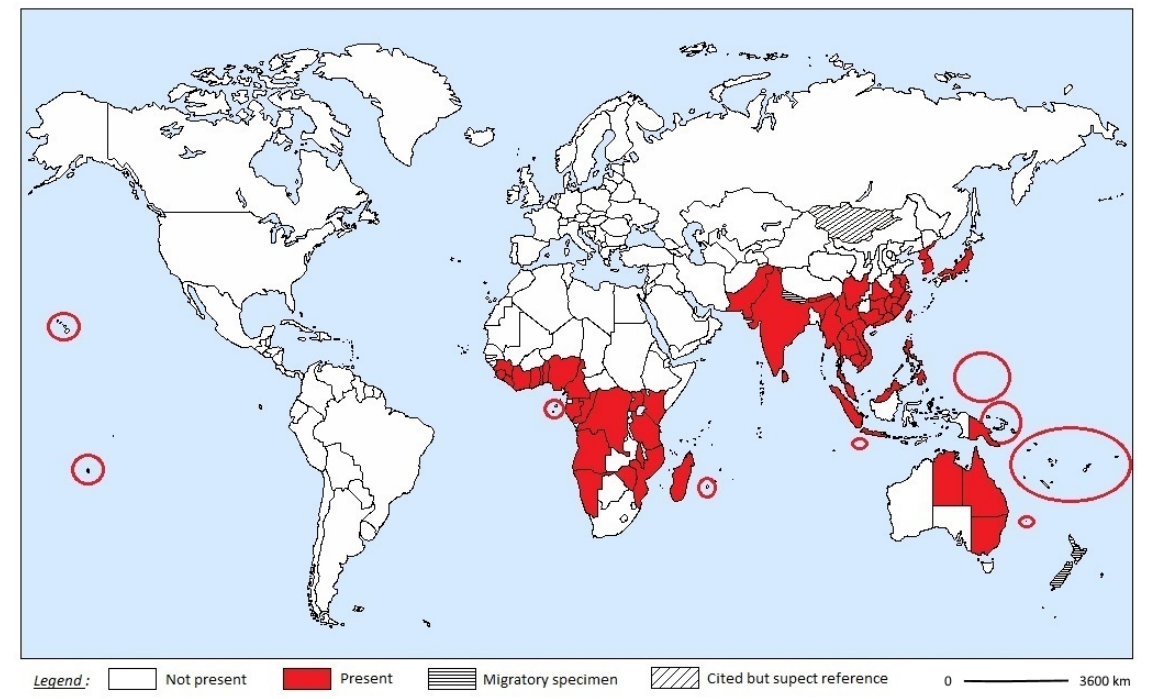
Figure 1. Distribution map of Eudocima phalonia based on available references.